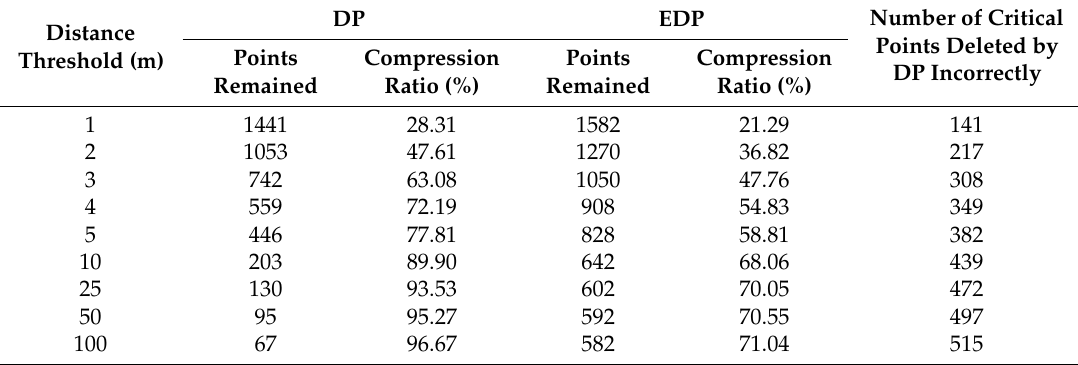
Table 3. Points and critical points preserved by DP and EDP algorithms for Trajectory